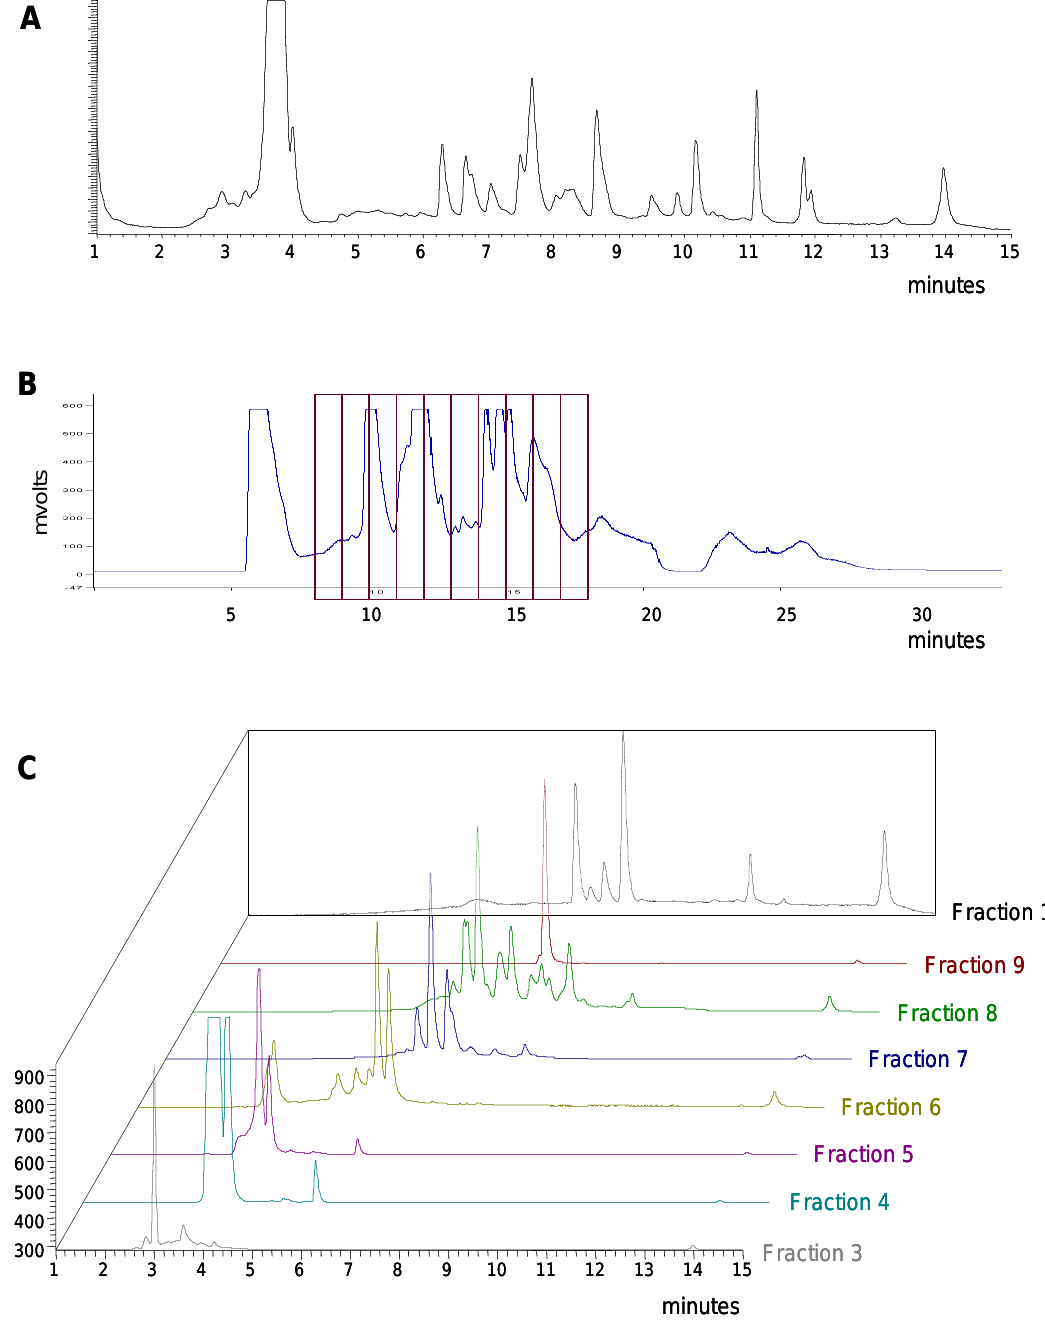
Figure 3. HPLC chromatograms of fungal extract 70360-F11. A) Analytical HPLC- ELSD chromatogram of the crude methanol extract 70360-F11. B) Preparative LC chromatogram of the crude methanol extract 70360-F11 (UV detection at 254 nm) with the fraction collection outlined. C) HPLC-ELSD chromatograms of fractions 3 through 10 from the preparative LC run of 70360-F11 shown in